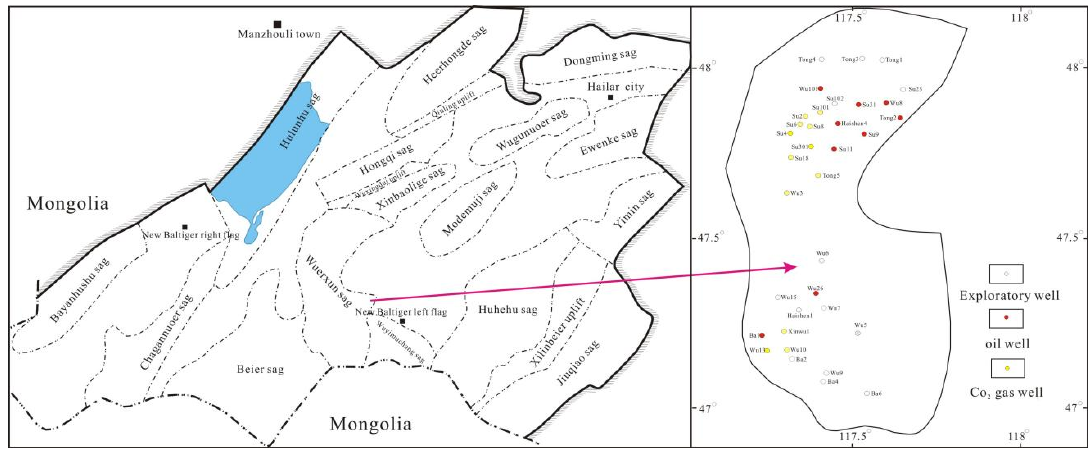
Figure 1. The location and drilling distribution map of Wuerxun depression.